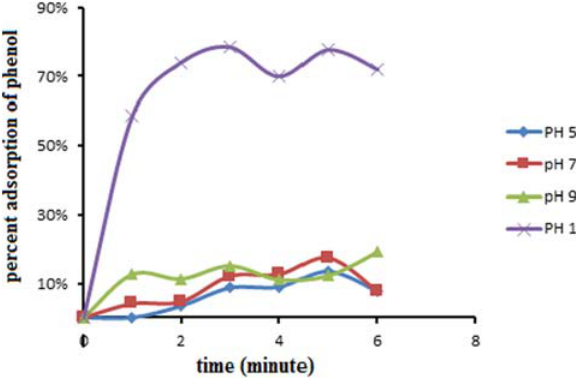
Figure 6: E ff ect of pH and contact time on percent adsorption of phenol at MSA 3